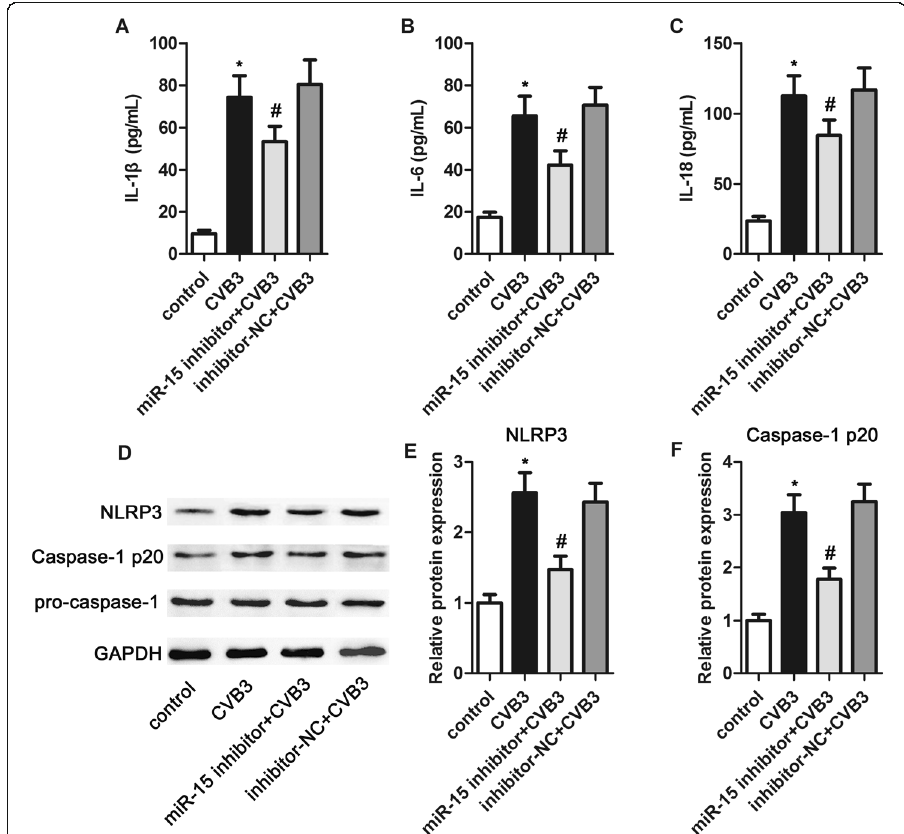
generation of IL-1 β ( a ), IL-6 ( b ) and IL-18 ( c ) was determined using ELISA. d through f – The protein expressions of NLRP3, caspase-1 p20 and pro-caspase-1 were determined using western blotting with corresponding histogram analysis, normalizing to GAPDH expression. * p < 0.05 versus the control group, # p < 0.05 versus the CVB3